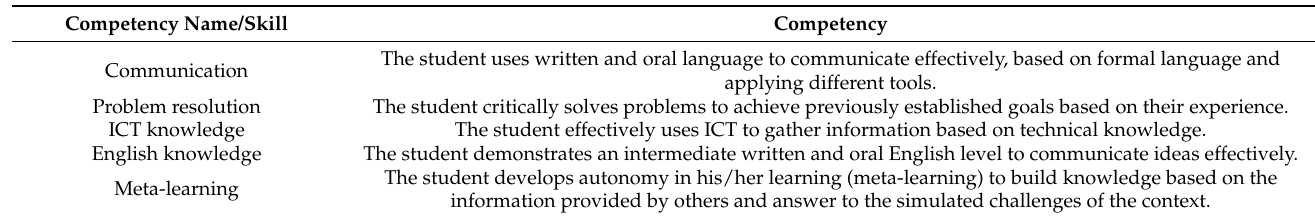
Table 3. Formulated competencies from the admission